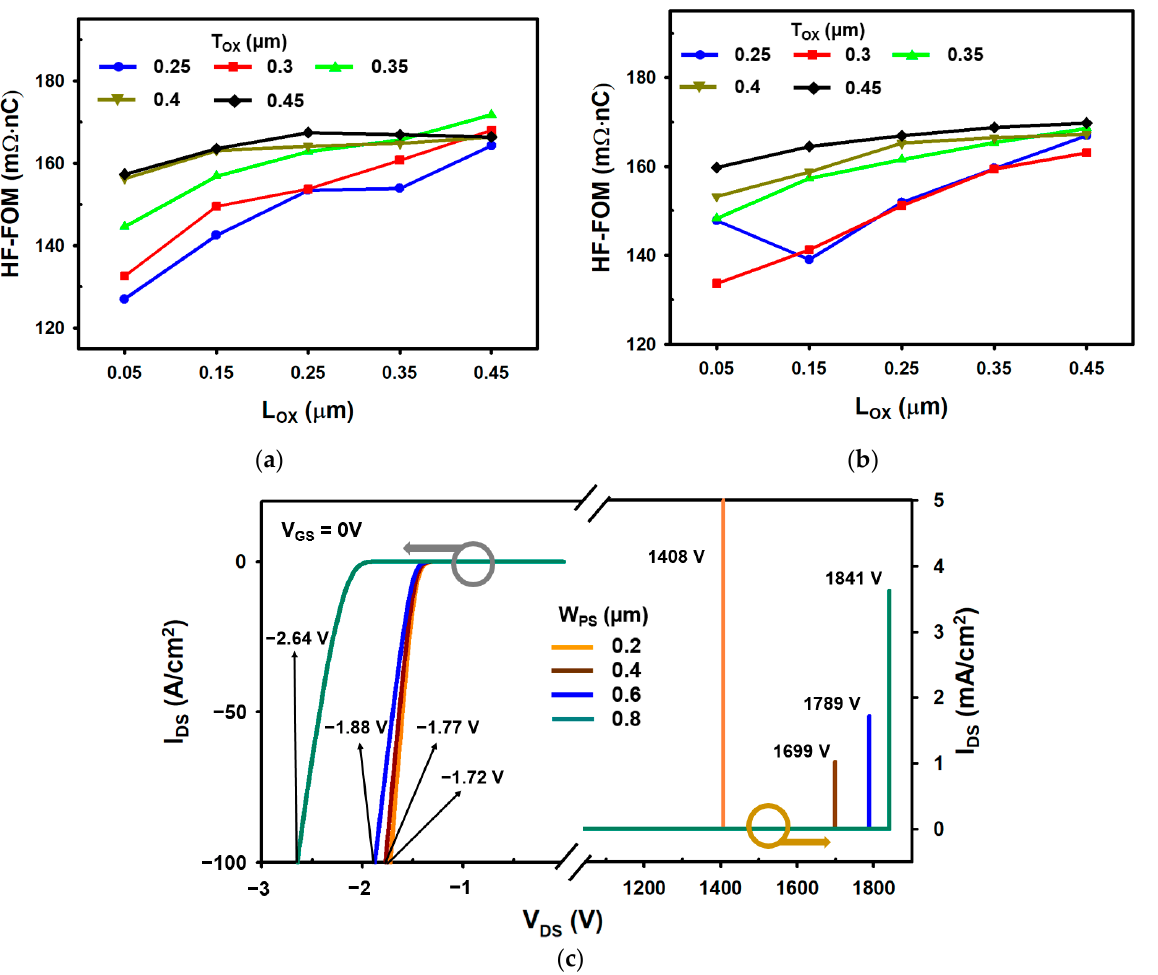
Figure 9. ( a ) HF-FOM of SG-DTMOS with varied L ox and T ox . ( b ) HF-FOM of SHG-DTMOS with varied L ox and T ox . ( c ) Influence of W PS on forward conduction characteristics and breakdown voltage of SHG-DTMOS.